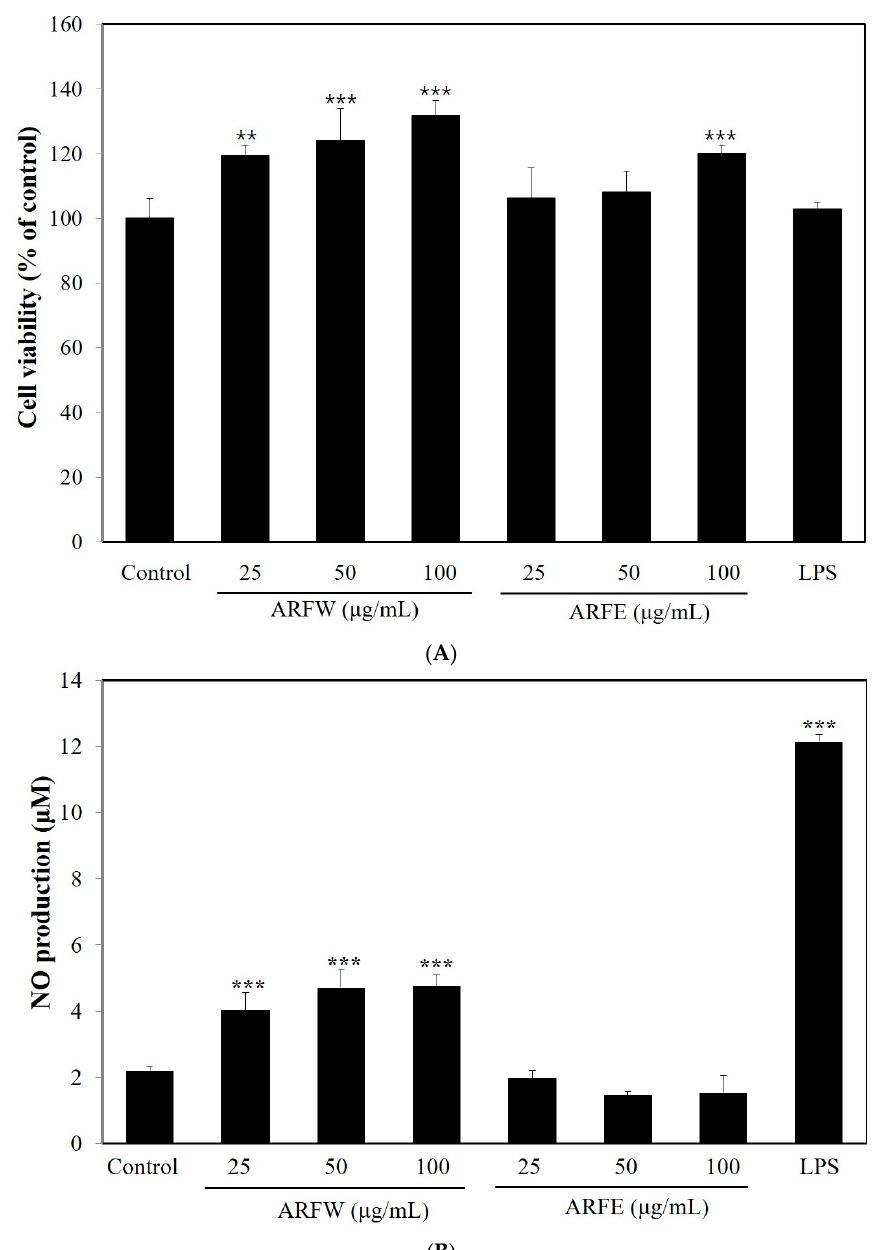
Figure 1. A. rosea flower extracts were not toxic to murine macrophage RAW264.7 cells ( A ) A. rosea flower water extracts (ARFW) induced the production of NO; ( B ) The cell viability was determined by MTT assay. ARFW, ARFE and lipopolysaccharide (LPS, 100 ng/mL) showed no cytotoxicity on RAW264.7 cells with 100 μ g/mL maximum concentration for 24 h. NO production was induced by ARFW, but not by ARFE. ** p < 0.01, *** p < 0.001 vs. control.